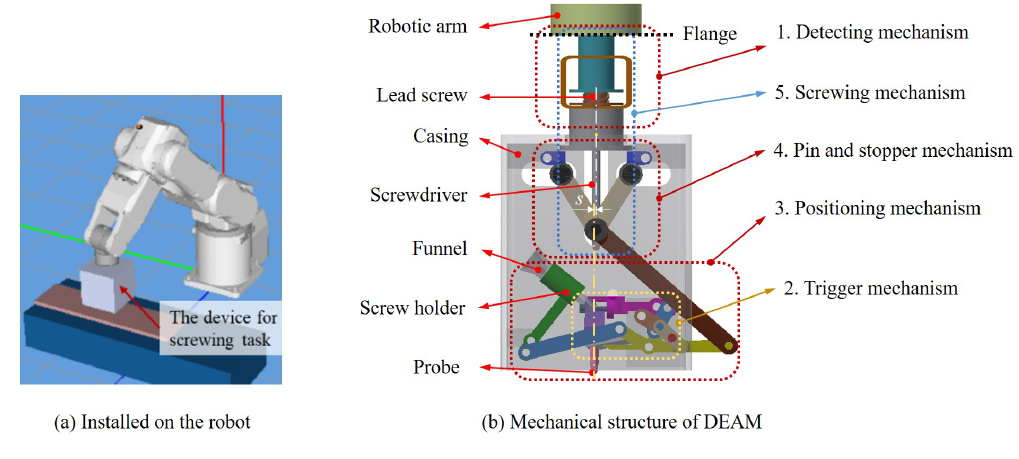
Figure 1. Design concept.